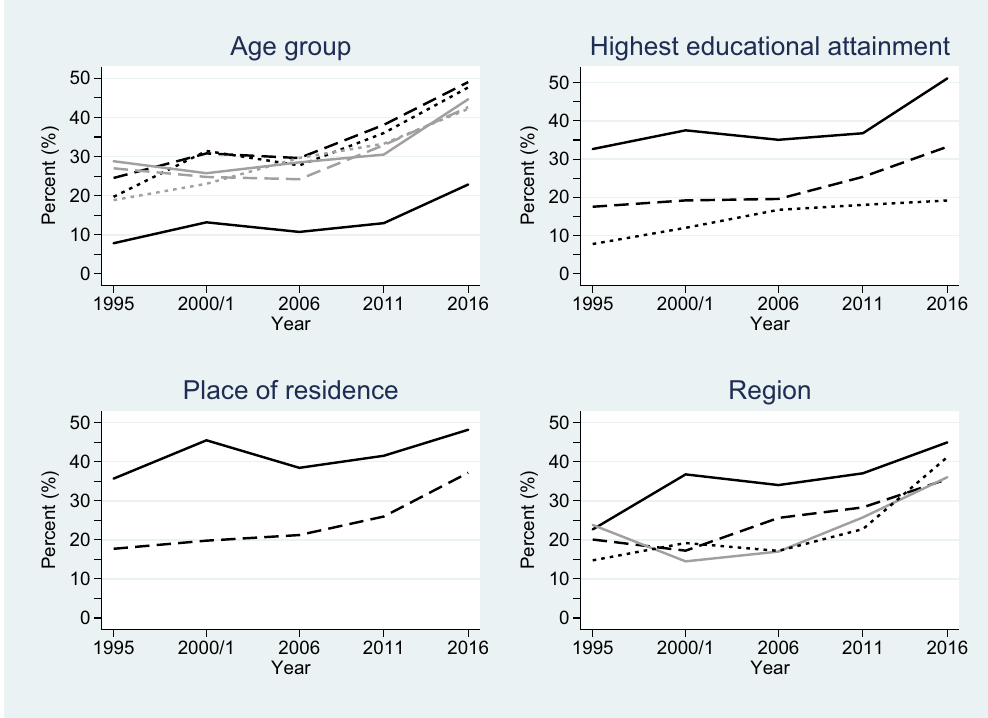
Fig 4. Changes in any contraceptive use among men in Uganda across the study period (1995–2016), partitioned by the considered demographic variables. Key: age group (years): 15–19 (black/solid); 20–24 (black/dash); 25–29 (black/dot); 30– 34 (grey/solid); 35–39 (grey/dash); � 40 (grey/dot); highest educational attainment: secondary and higher (solid); primary (dash); none (dot); place of residence: urban (solid); rural (dash); and region: Central (black/solid); East (dash); West (dot); North